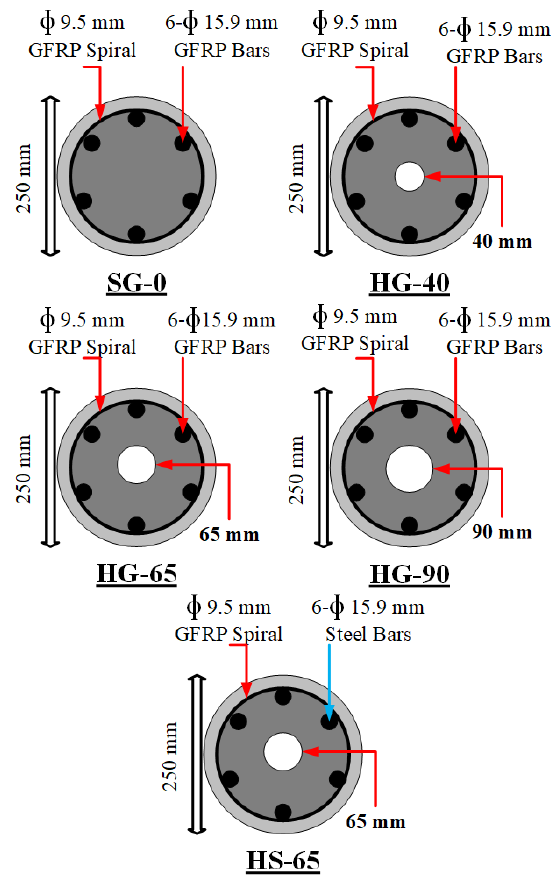
Figure 2. Cross sections of column